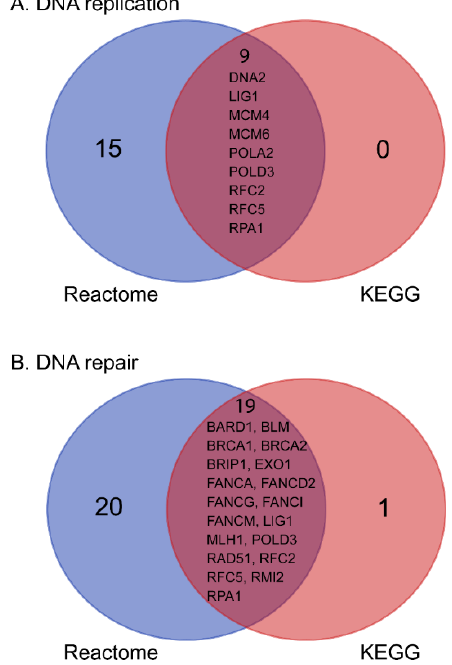
Figure 4. Common up-regulated genes in response to polymyxin treatment shared by Reactome and KEGG. ( A ) Shared up-regulated DEGs in the DNA replication pathway; ( B ) shared up-regulated DEGs in the DNA repair pathway.